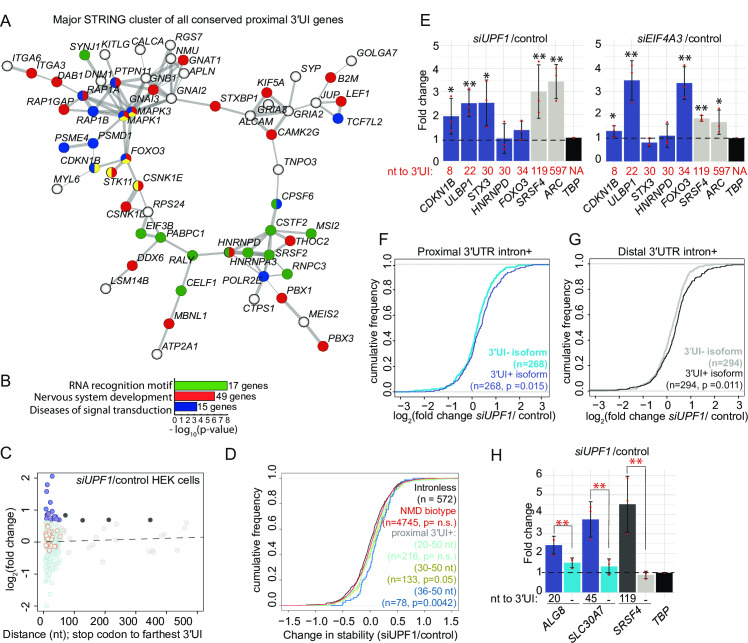
Proximal position of 3′UTR introns is conserved in many vertebrate genes and a subset of proximal 3′UI-containing genes are NMD-sensitive in human cells.A. A major interaction cluster predicted by STRING network analysis of genes with a 3′UI in proximal position in zebrafish, mouse and human. Nodes are colored by gene/protein function: nervous system (red), presence of RNA recognition motif (RRM) (green), diseases of signal transduction (blue), FoxO signaling pathway (yellow). (167 nodes and 127 edges in total, PPI enrichment p-value = 0.02). B. Gene ontology enrichment analysis of all 167 genes with conserved 3′UI proximal positioning. The most significant GO term within the following functional categories are shown: Interpro domains, Biological process and Reactome pathways. C. A scatter plot showing fold changes for APPRIS-annotated proximal 3′UI transcripts (dark blue: FC > 1.5 and light blue: FC < 1.5) and distal 3′UI transcripts (black: FC > 1.5 and gray: FC < 1.5) in UPF1 knockdown HEK293 cells compared to control cells [57]. Dots encircled in red are transcripts that also contain an uORF as determined previously in [57]. Same analysis for Ensembl transcript annotations is shown in Fig S5G. D. Empirical CDF plot showing change in mRNA stability for different classes of NMD targets and intron-less genes upon UPF1 knockdown in HEK293 cells (data from [57]). The gene classes are as follows: proximal 3′UI-containing genes where distance is 20–50 nts (light green), 30–50 nts (olive green) and 36–50 nts (dark blue), Ensembl-annotated NMD-biotype genes (red) and intron-less genes (black). CDF function is plotted as in Fig 5B. KS test p-value for comparison of NMD targets to intron-less genes is indicated in the same color. E. qRT-PCR analysis showing fold changes for proximal 3′UI-containing genes CDKN1B, FOXO3 (upregulated in zebrafish); ULBP1; STX3 (highest change in stability upon UPF1 KD in HEK293 cells [57]); HNRNPD (encodes RRM-containing protein) and distal 3′UI-containing genes (ARC and SRSF4) upon UPF1 (left) and EIF4A3 (right) knockdown in HCT116 cells. The distance between stop codon and 3′UI for every 3′UI-containing gene is indicated below each bar. TBP is the normalizing gene used for qRT-PCR analysis. Welch’s t-test p-values are indicated using asterisks (** p-value < 0.05 and * p-value < 0.1). F. Empirical CDF plot of fold changes in levels of 3′UI-containing isoforms (dark blue) as compared to 3′UI-lacking isoforms (sky blue) encoded from same genes in UPF1-depleted HEK293 cells. KS test p-value for differences in the two distributions is indicated on the bottom right. G. CDF plot as in F showing the fold changes in levels of distal 3′UI-containing (black) versus 3′UI-lacking isoforms (gray). H. qRT-PCR analysis showing fold changes for 3′UI-containing and 3′UI-lacking isoforms encoded by proximal 3′UI-containing genes ALG8 and SLC30A7 and by a distal 3′UI-containing gene SRSF4 upon UPF1 knockdown in HCT116 cells. The distance of 3′UI when present, or its absence (-) is indicated below each bar. TBP is the normalizing gene used for qRT-PCR analysis. Welch’s t-test p-values for the three biological replicates of each transcript are < 0.05. The Welch’s paired t-test p-values for the comparison between fold changes of 3′UI-containing and 3′UI-lacking isoforms is indicated using red asterisks (** p-value < 0.05).